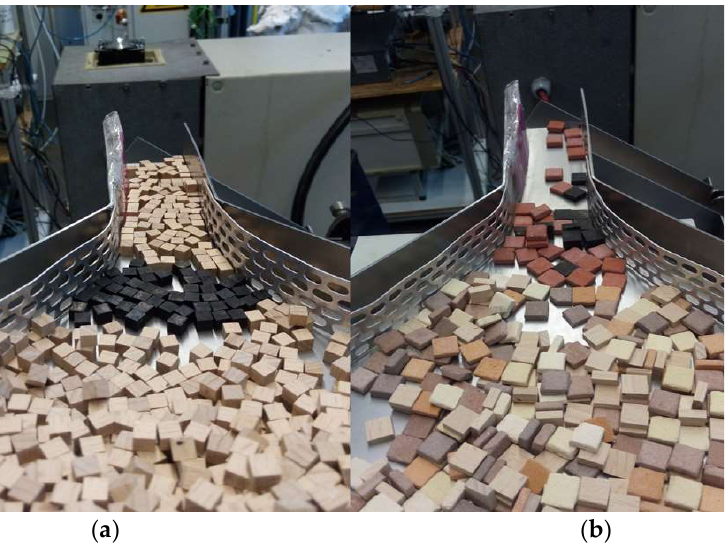
Figure 4. Introduction of tracers into the feeder for single component and two components, ( a ) black tracer for 6 mm cubes ( b ) black wood tracer and red ceramic tracer for wood-ceramic mixture (x wood = 0.25).